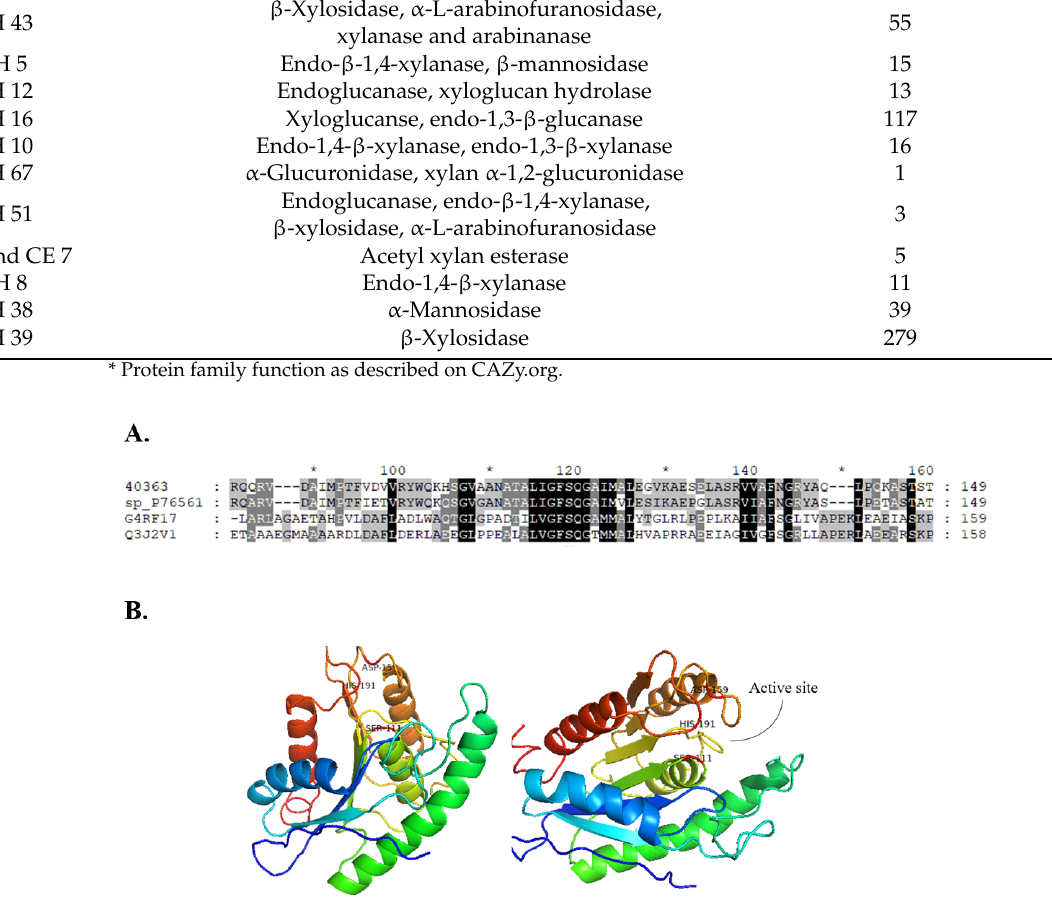
Figure 2. MSA and homology model. ( A ) The sequence of Gene_id_40363 was aligned with selected members of the abhydrolase_2 protein family. The function and source of aligned sequences (from top to bottom) are 40363 (Gene_id_40363, metagenomic sequence), sp_P76561 (esterase YpfH from Escherichia coli ), Q3J2V1 (phospholipase/carboxylesterase from Rhodobacter sphaeroides ), and G4RF17 (phospholipase/carboxylesterase from Pelagibacterium halotolerans ). ( B ) The homology model of Gene_id_40363 was developed in I-Tasser and displayed in PyMOL. Catalytic residues are annotated as S111, D159, and H191.